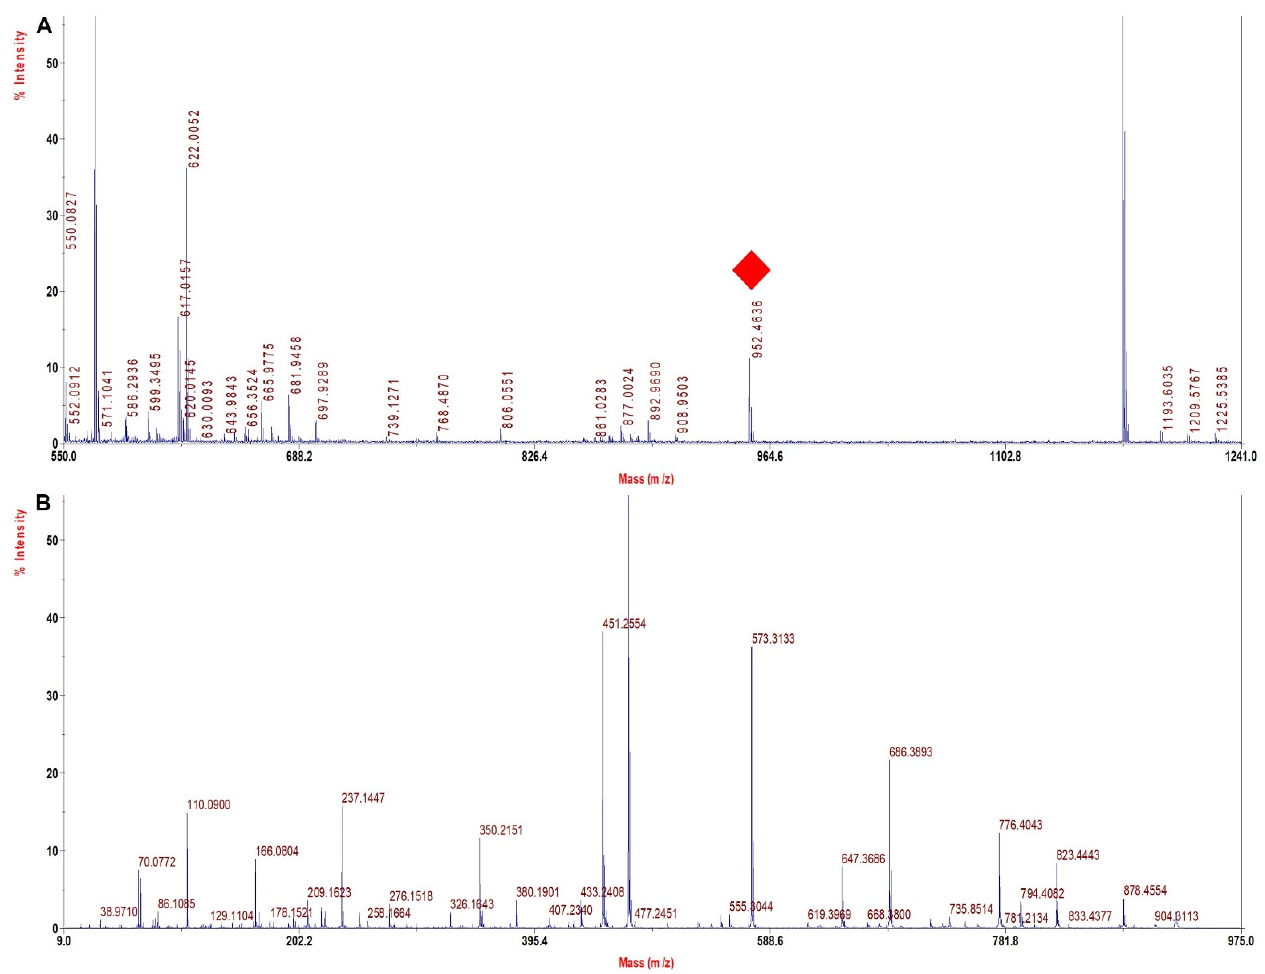
Figure 7. MALDI − MS and MALDI MS/MS spectra for the signature peptide from HbS homozygous (1909) Beta 6 (A3) Glu > Val ( A ). PMF spectrum showing signature peptide obtained by TFE treated in − solution tryptic digestion. ( B ). MALDI − MS/MS spectrum of the signature peptide 922.4 m/z of HbS homozygous sample.